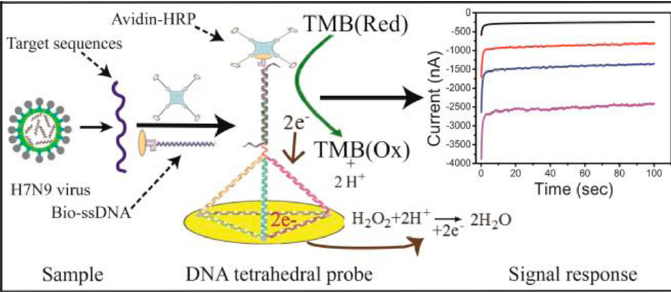
Figure 12. Diagram of DNA tetrahedral probe [34]. Copyright 2015. Reproduced with permission from American Chemical Society.